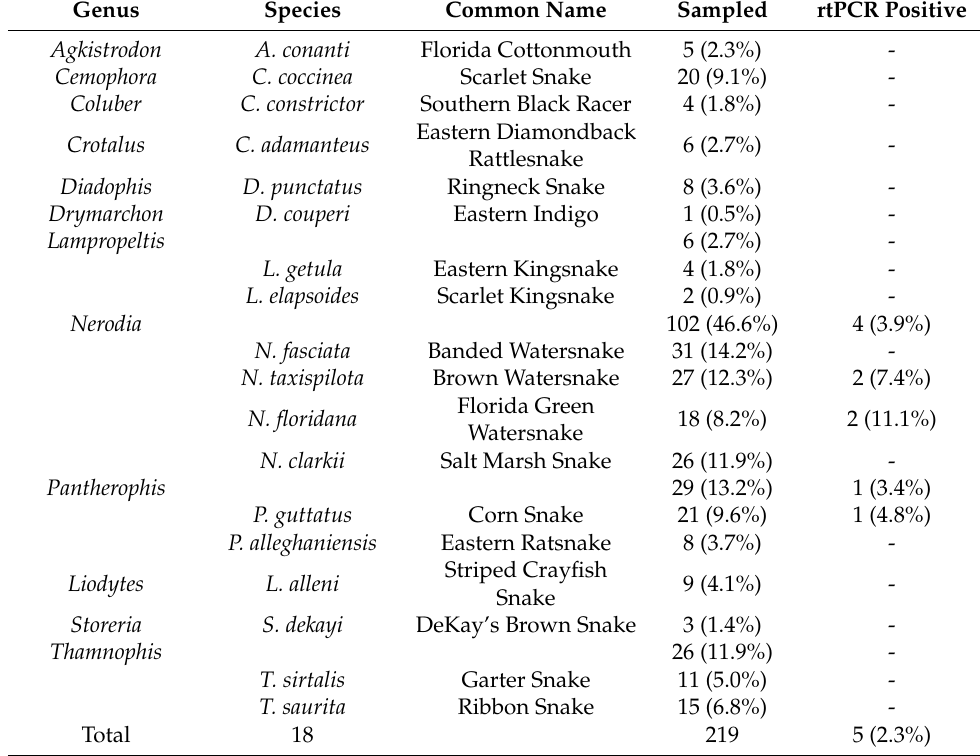
Table 1. Florida native snake species sampled and tested by reverse transcription PCR (rtPCR) for serpentovirus. The ‘Sampled’ column represents the number of samples and proportion to total samples for each genus and species (same row if single species is represented). Likewise, the ‘rtPCR Positive’ column represent the number and serpentovirus prevalence via rtPCR for each genus and